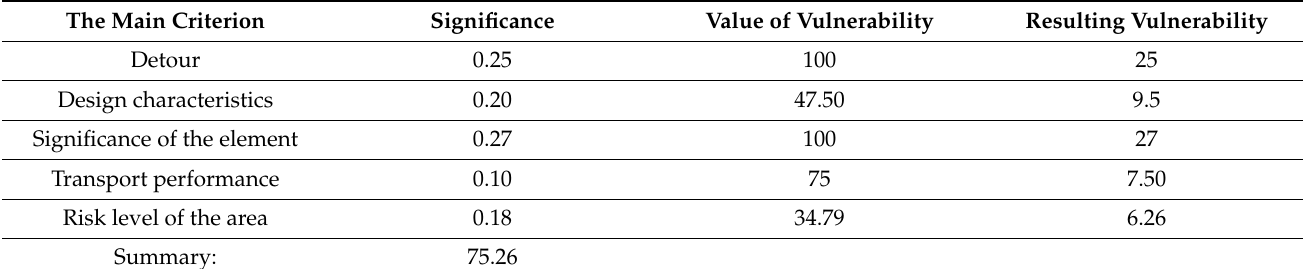
Table 16. Calculation of Vulnerability for Streˇcno I Tunnel.